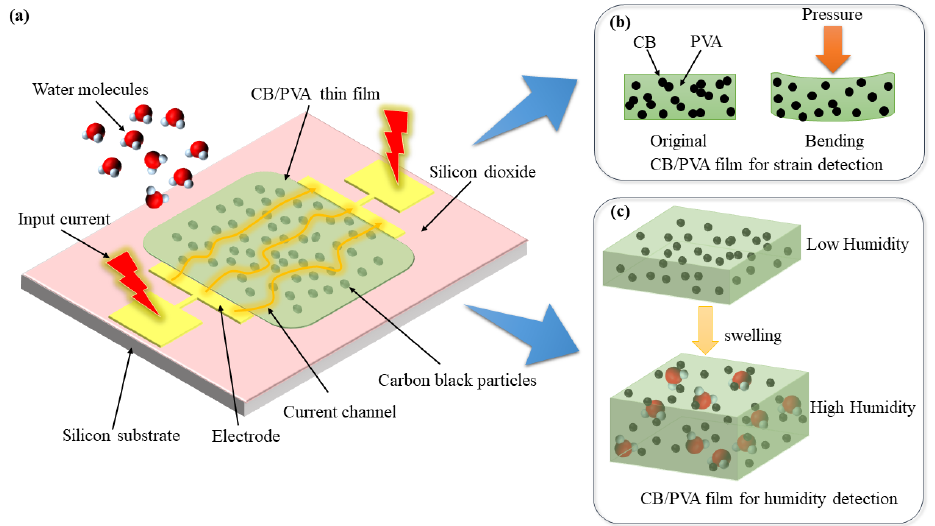
Figure 1. Structure and mechanism of CB/PVA film sensor. ( a ) Schematic diagram of CB/PVA film structure design. ( b , c ) Schematic diagram of the mechanism of CB/PVA film for strain detection ( c ) and humidity detection ( b ).